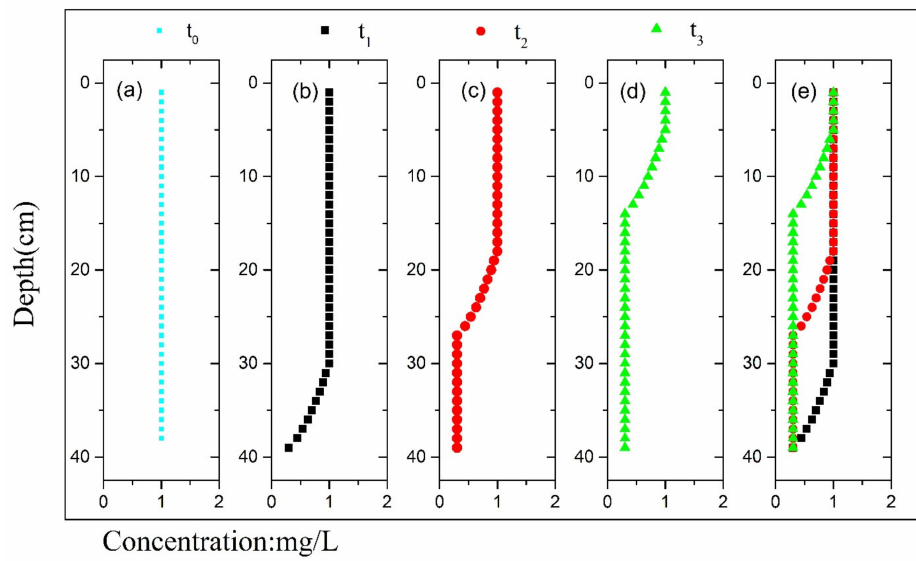
Figure 1. Theoretical concentration profiles of uniform injection at: ( a ) initial time t 0 ; ( b ) first observation time t 1 ; ( c ) second observation time t 2 ; ( d ) at third observation time t 3 . ( e ) the overlay chart of ( b – d ). Note that the time interval between two observation times is